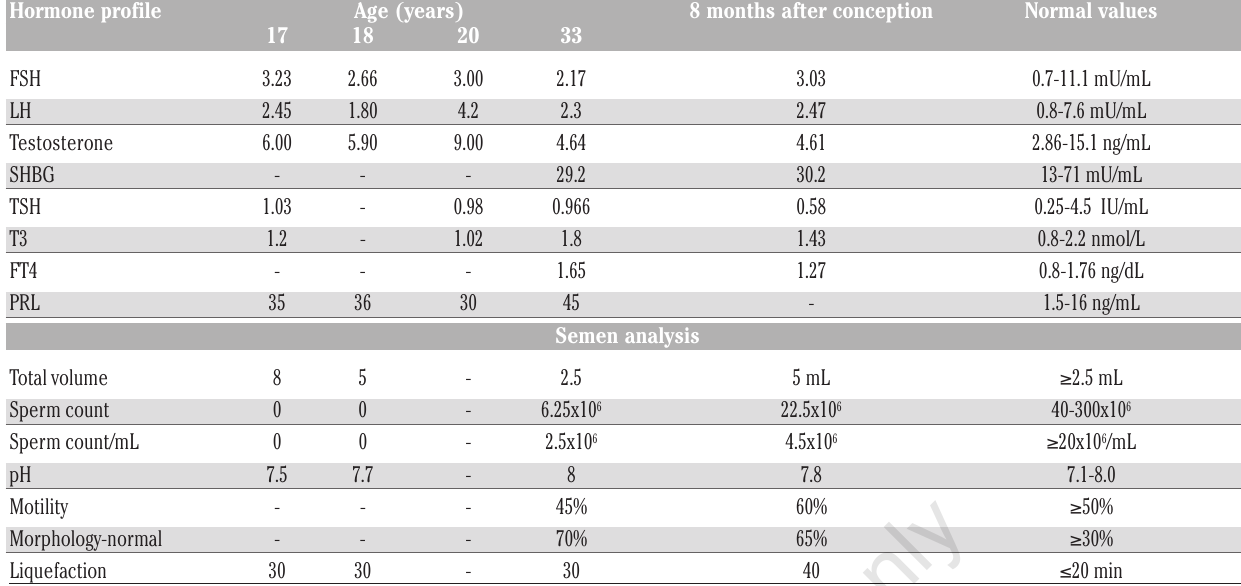
Table 1. Hormone profile and semen analysis. Hormone profile